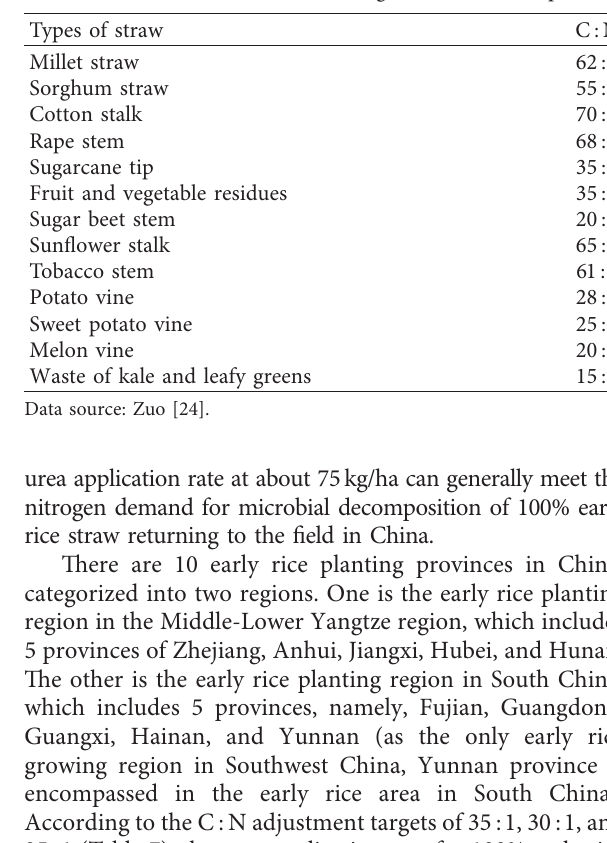
25 :1 (Table 7), the urea application rate for 100% early rice